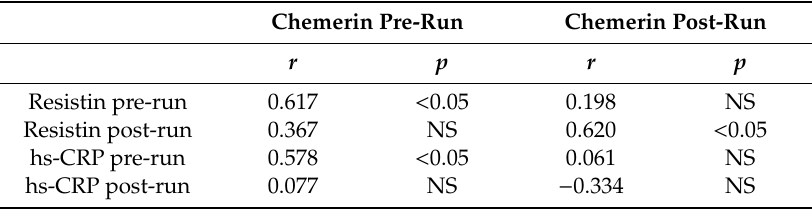
Table 4. Spearman coe ffi cients correlation of pre- and post-run chemerin levels with levels of resistin and hs-CRP. Chemerin Pre-Run Chemerin Post-Run